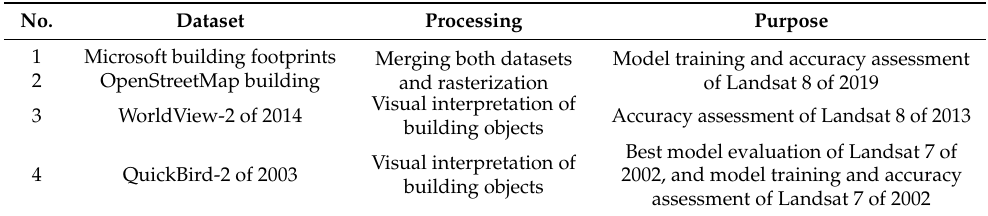
Table 2. Sources of building datasets used in this